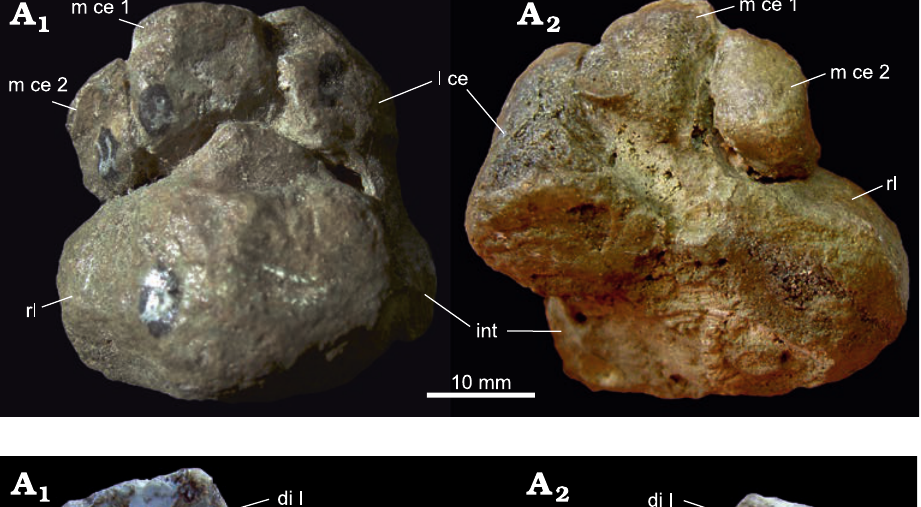
Fig. 9. Medial part of the carpus of Therio­ gnathus microps Owen, 1876, NHMUK R 5694, Thaba ‘Nchu, South Africa, Cistece­ pha lus Assemblage Zone, Lopingian, with three centralia. Dorsal (A 1 ) and distoven- tral (A 2 ) views. Abbre via tions: int, inter- medium; l ce, lateral centrale; m ce, medial centrale; rl, radiale.